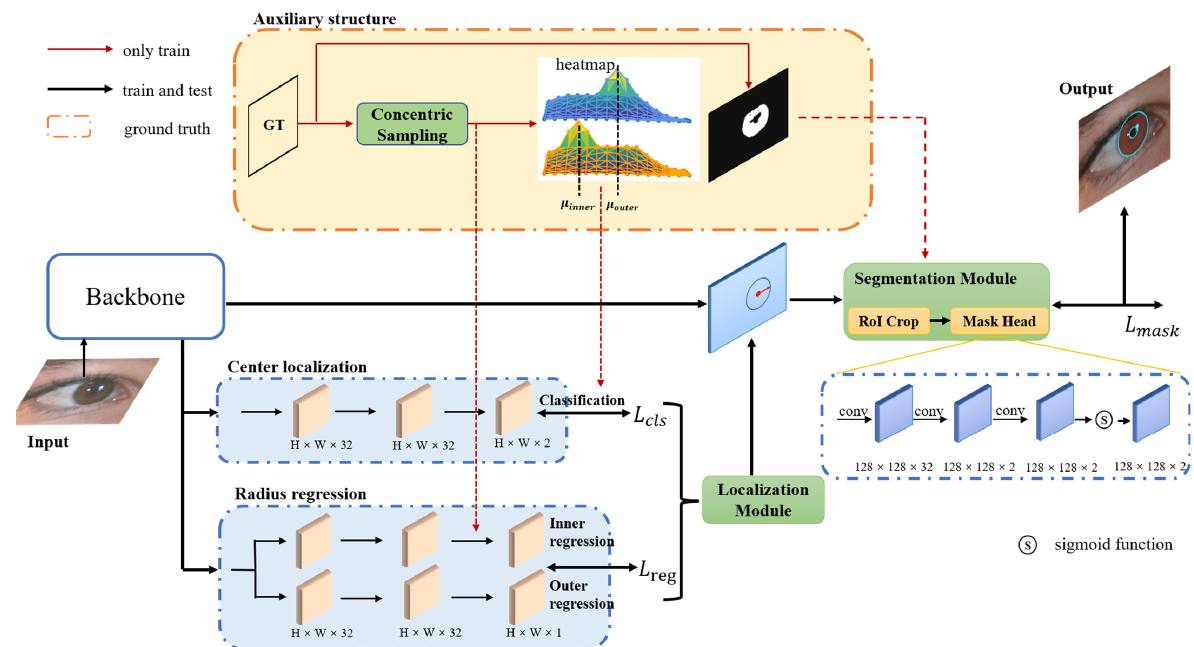
Figure 4. Architecture of ICSNet. Subnets in the three blue boxes are the center localization head, radius regression head, and mask head. Subnets in the orange box are the concentric sample operations, red arrow is the data flow, and our concentric sampling strategy is completely cost ‐ free in inference time because auxiliary structures only exist during training. The localization module includes the classification and regression heads, which predict the circle bounding box. The mask module includes crop operation and mask head, which are responsible for cropping the iris region from the feature map and producing the segment iris mask.